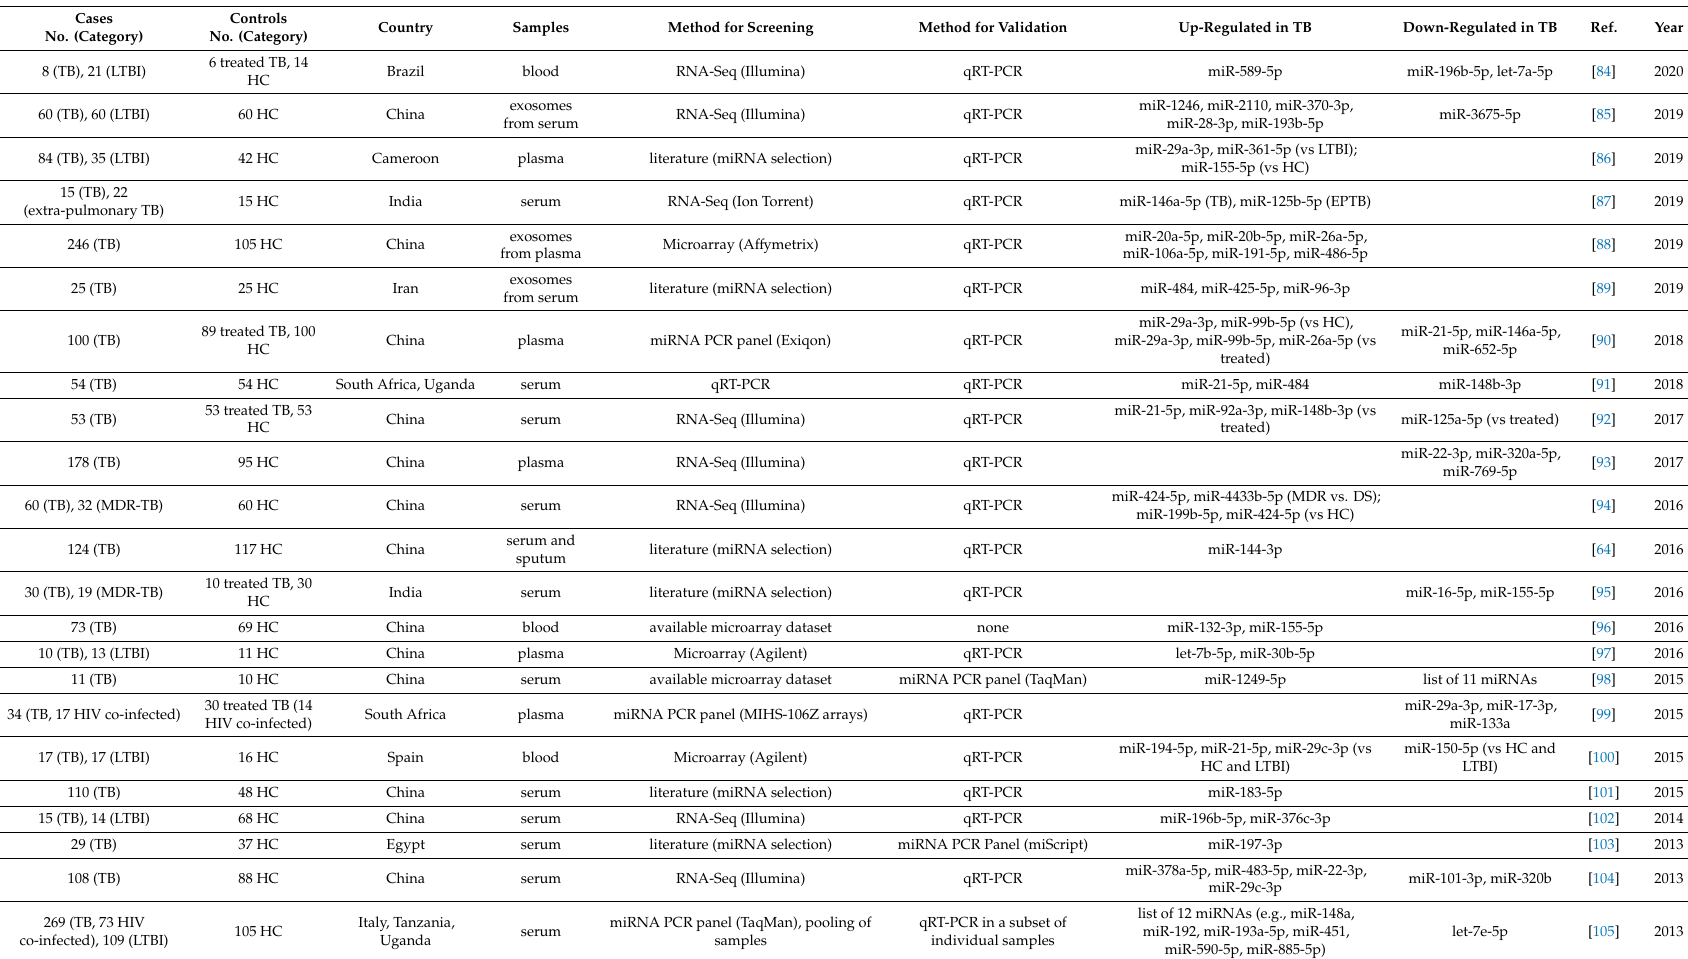
Table 2. Summary of studies on miRNA biomarker discovery in blood samples from TB subjects and